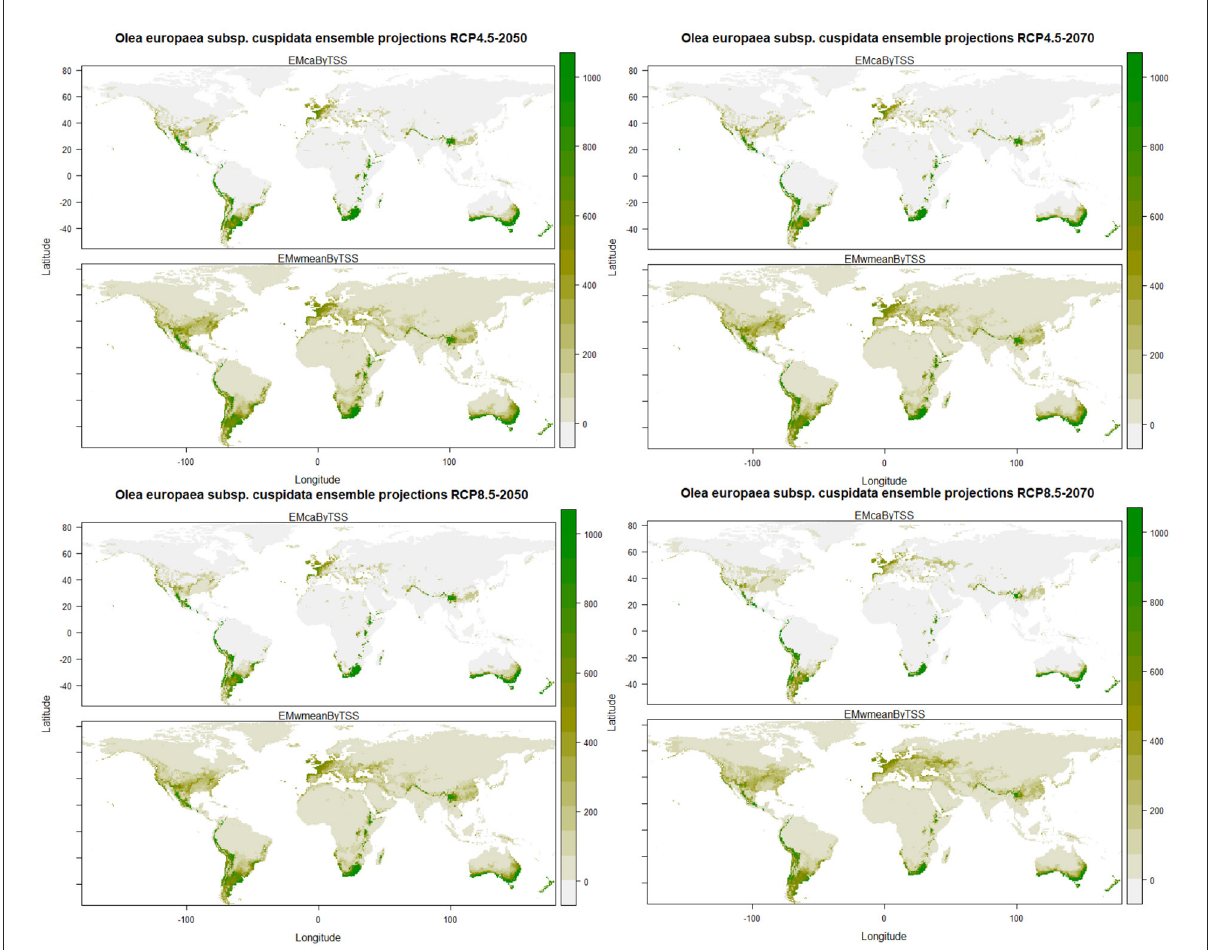
FIGURE3 Plots of the predicted habitat suitability for Olea europaea subsp. cuspidata under future climate change